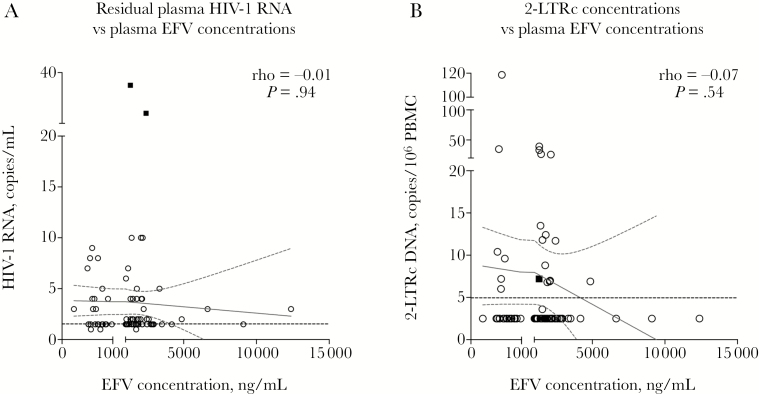
Relationship between efavirenz (EFV) plasma concentrations and (A) residual plasma HIV-1 RNA and (B) 2-LTR circular HIV-1 DNA (2-LTRc DNA) among 76 patients who had taken the last EFV dose a median of 12 hours (interquartile range, 10–13) prior to sampling. Cutoffs in the x-axes represent the minimum effective concentration (MEC) recommended for wild-type virus (1000 ng/mL). The dotted black lines indicate the assay limit of detection (HIV-1 RNA = 3 copies/mL; 2-LTR DNA = 5 copies/106 peripheral blood mononuclear cell). Each circle represents 1 participant; the 2 solid squares represent the 2 patients with residual plasma HIV-1 RNA >11 copies/mL.